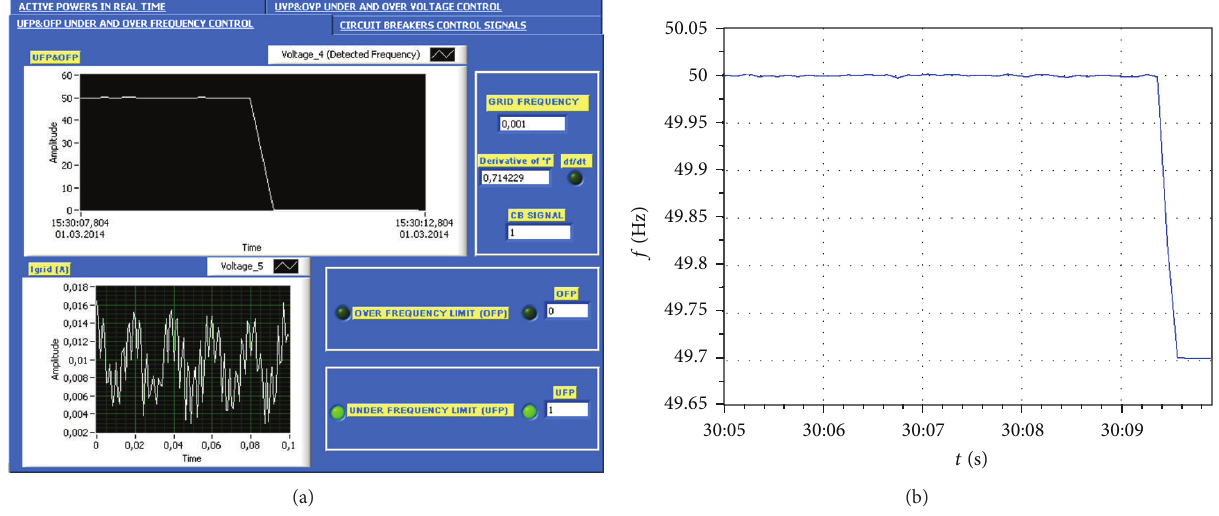
Figure 18: Frequency change of the system in real time (under frequency